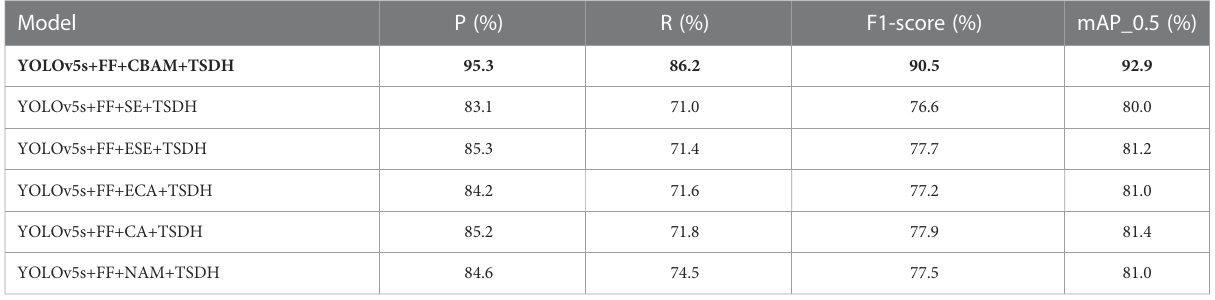
TABLE 6 Comparisons of different attention methods under the improved YOLOv5s.